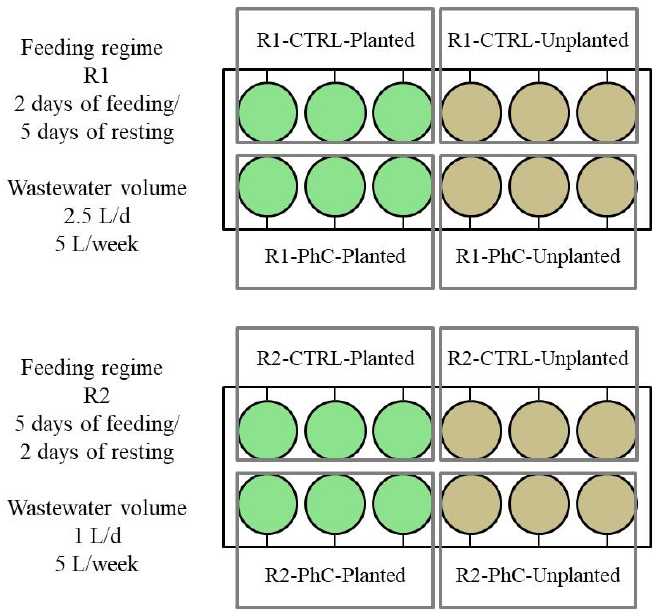
Figure 2. A scheme of the experimental system.